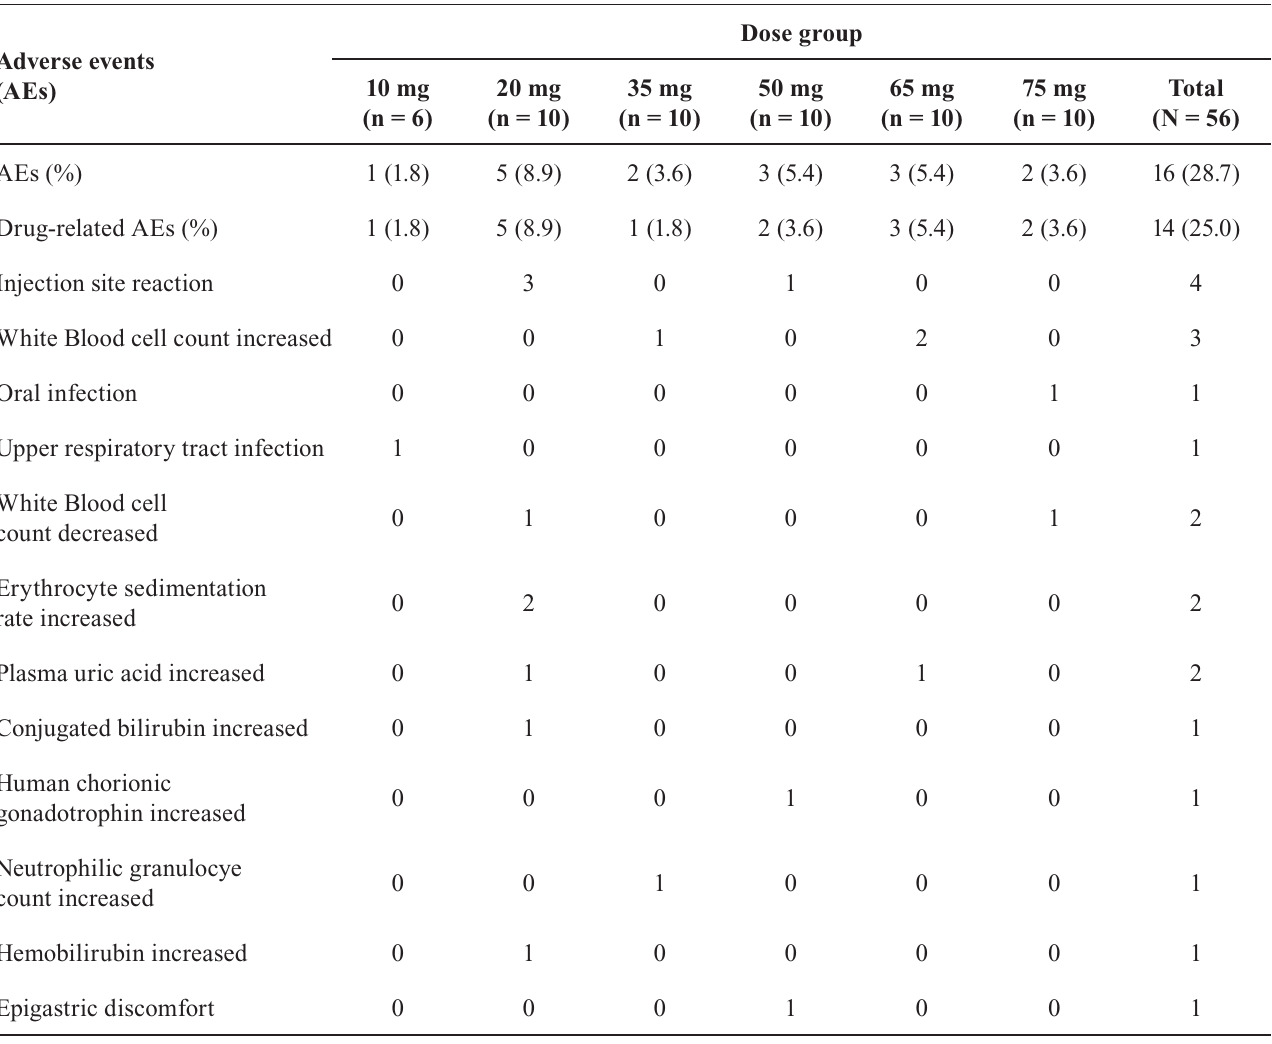
Data are presented as the number of AEs; N is the total number of subjects studied and n is the number of subjects in each